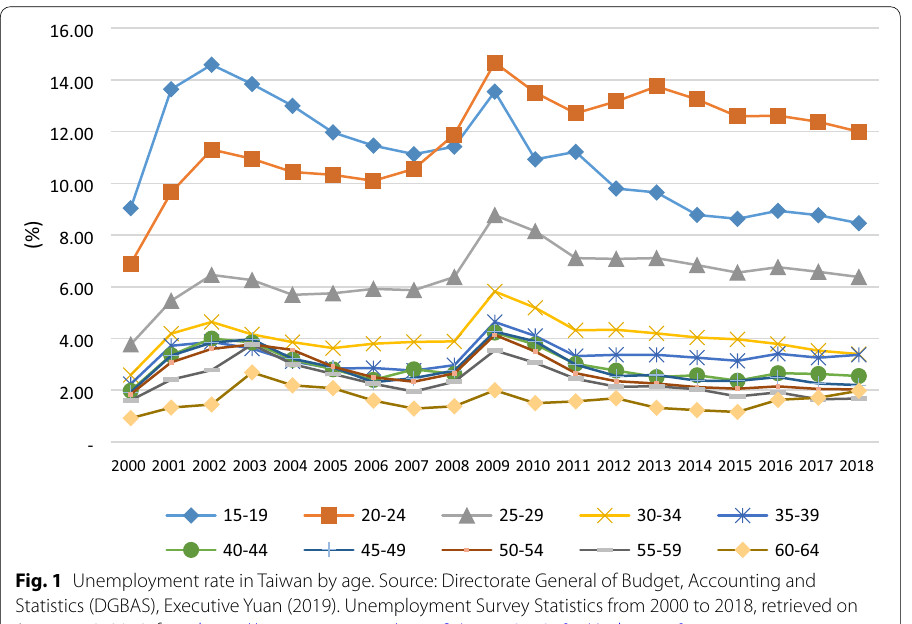
37135 & ctNode 517& mp = = =